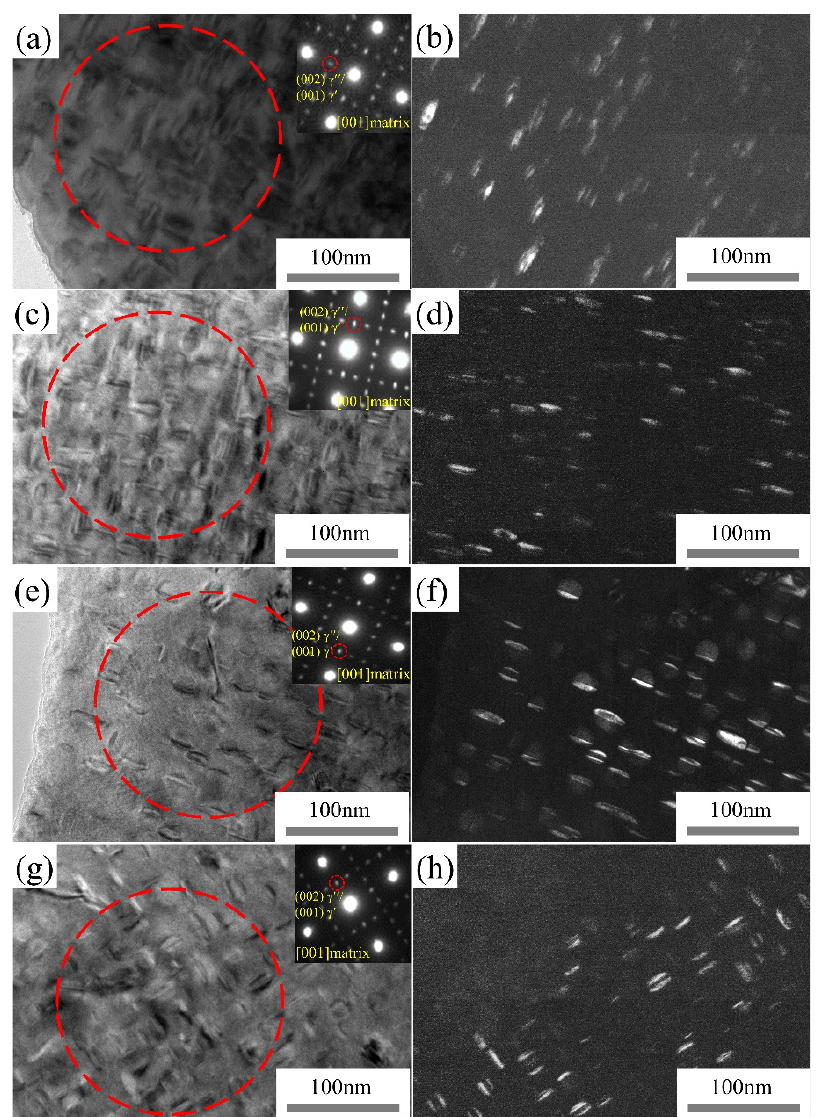
Figure 7. TEM analysis of γ’/γ” precipiate after post-treatment. ( a ) Bright field image and diffraction pattern of STA without NbC, and ( b ) Dark field image of STA without NbC. ( c ) Bright field image and diffraction pattern of STA with 0.5% NbC, and ( d ) dark field image of STA with 0.5% NbC. ( e ) Bright field image and diffraction pattern of DA without NbC, and ( f ) Dark field image of DA without NbC. ( g ) Bright field image and diffraction pattern of DA with 1% NbC, and ( h ) Dark field image of DA with 1% NbC.